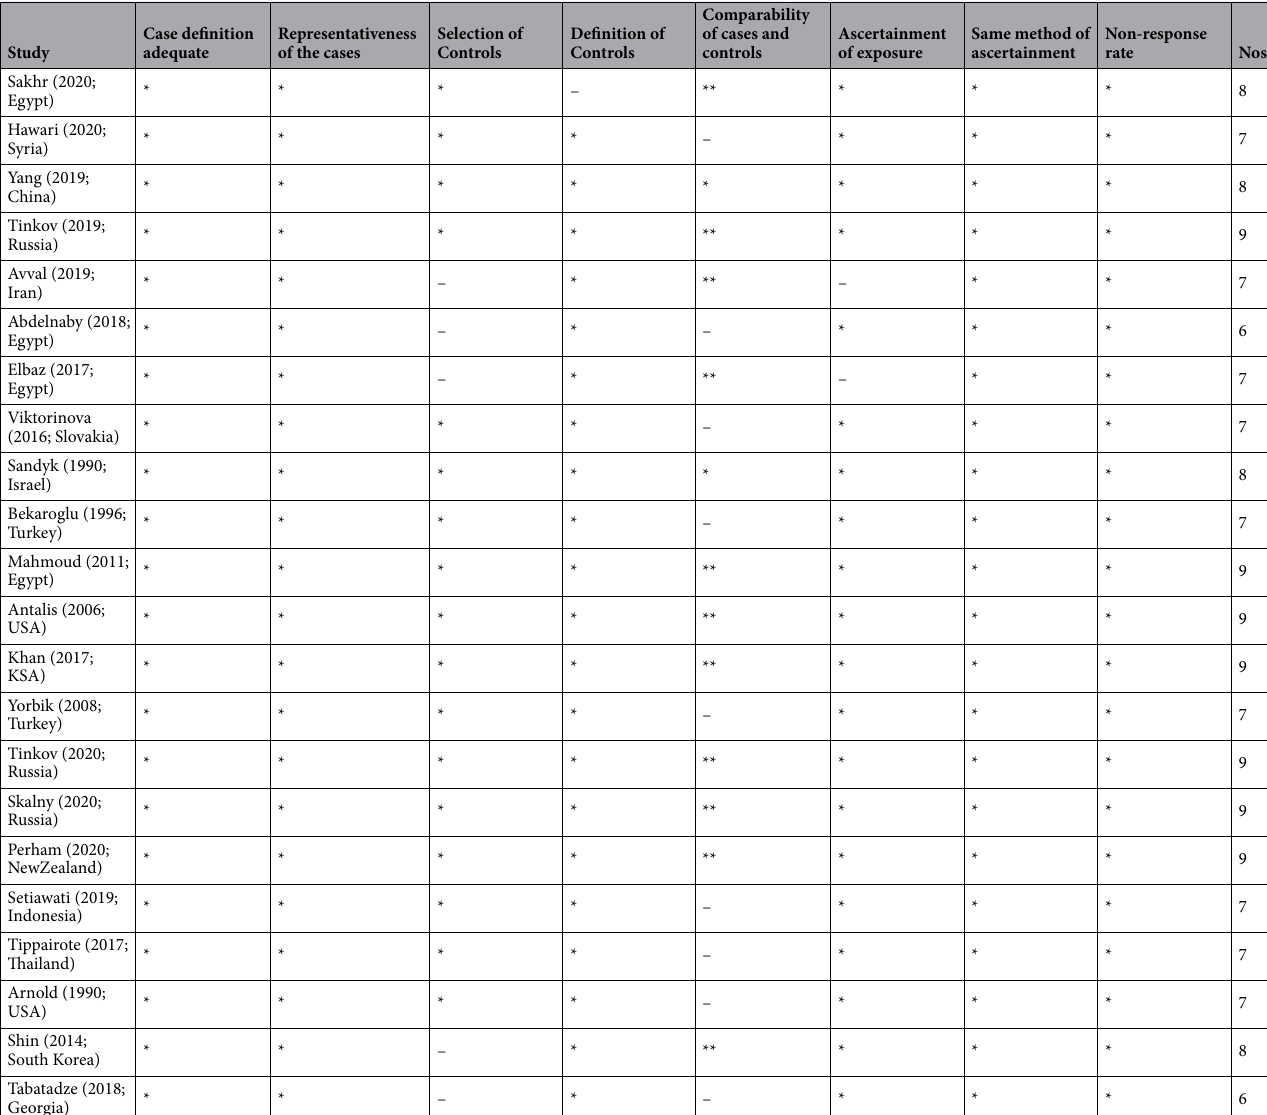
Table 2. Quality assessments of included studies. NOS New-castle Ottawa